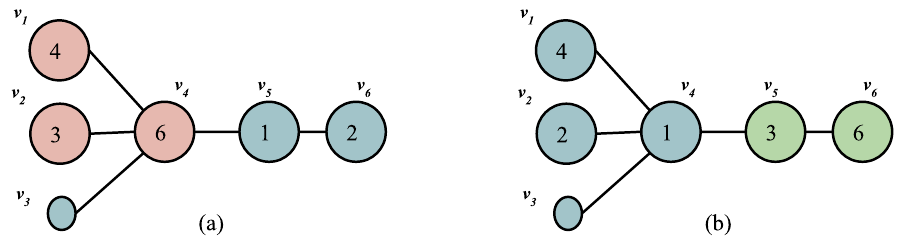
Figure 4. ( a ) S = (1, 2), (2, 6), (2, 3), (1, 6), (1, 3), (1, 4). ( b ) Modified Swap Sequence = (1, 6), (1, 3), (2, 6), (2,